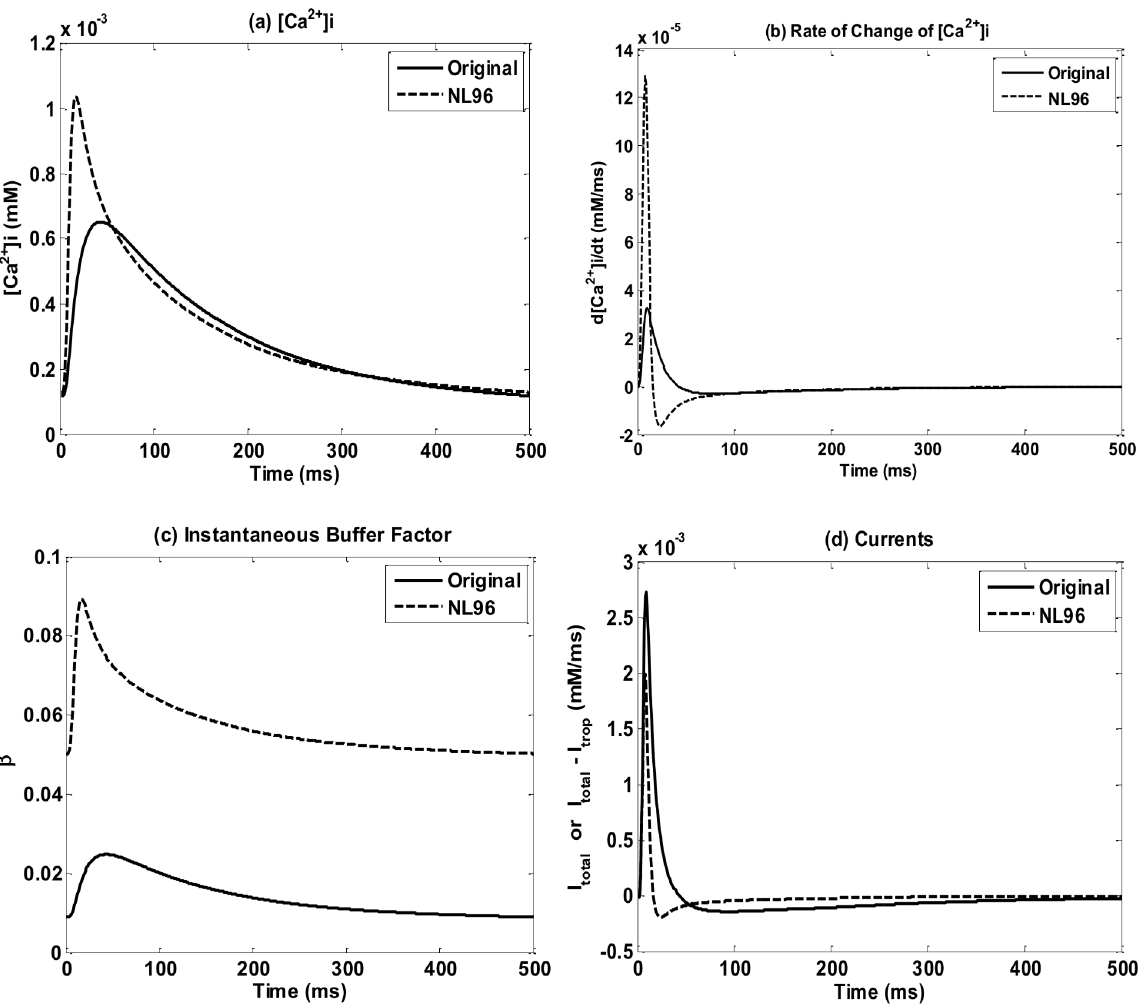
Fig 3. Ca 2+ shape changes for models with instantaneous buffers. Figures show the O ’ hara_etal_2008 model for: (a) [ Ca 2+ ] i (grey lines) and d [ Ca 2+ ] i / dt (black lines), before (solid lines) and after (dash lines) the implementation of NL96; (b) zoom in of d [ Ca 2+ ] i / dt ; (c) the instantaneous buffer factor β before (solid line) and after (dash line) the implementation of NL96; (d) intracellular Ca 2+ flux before (solid line) and after (dash line) the implantation of NL96.